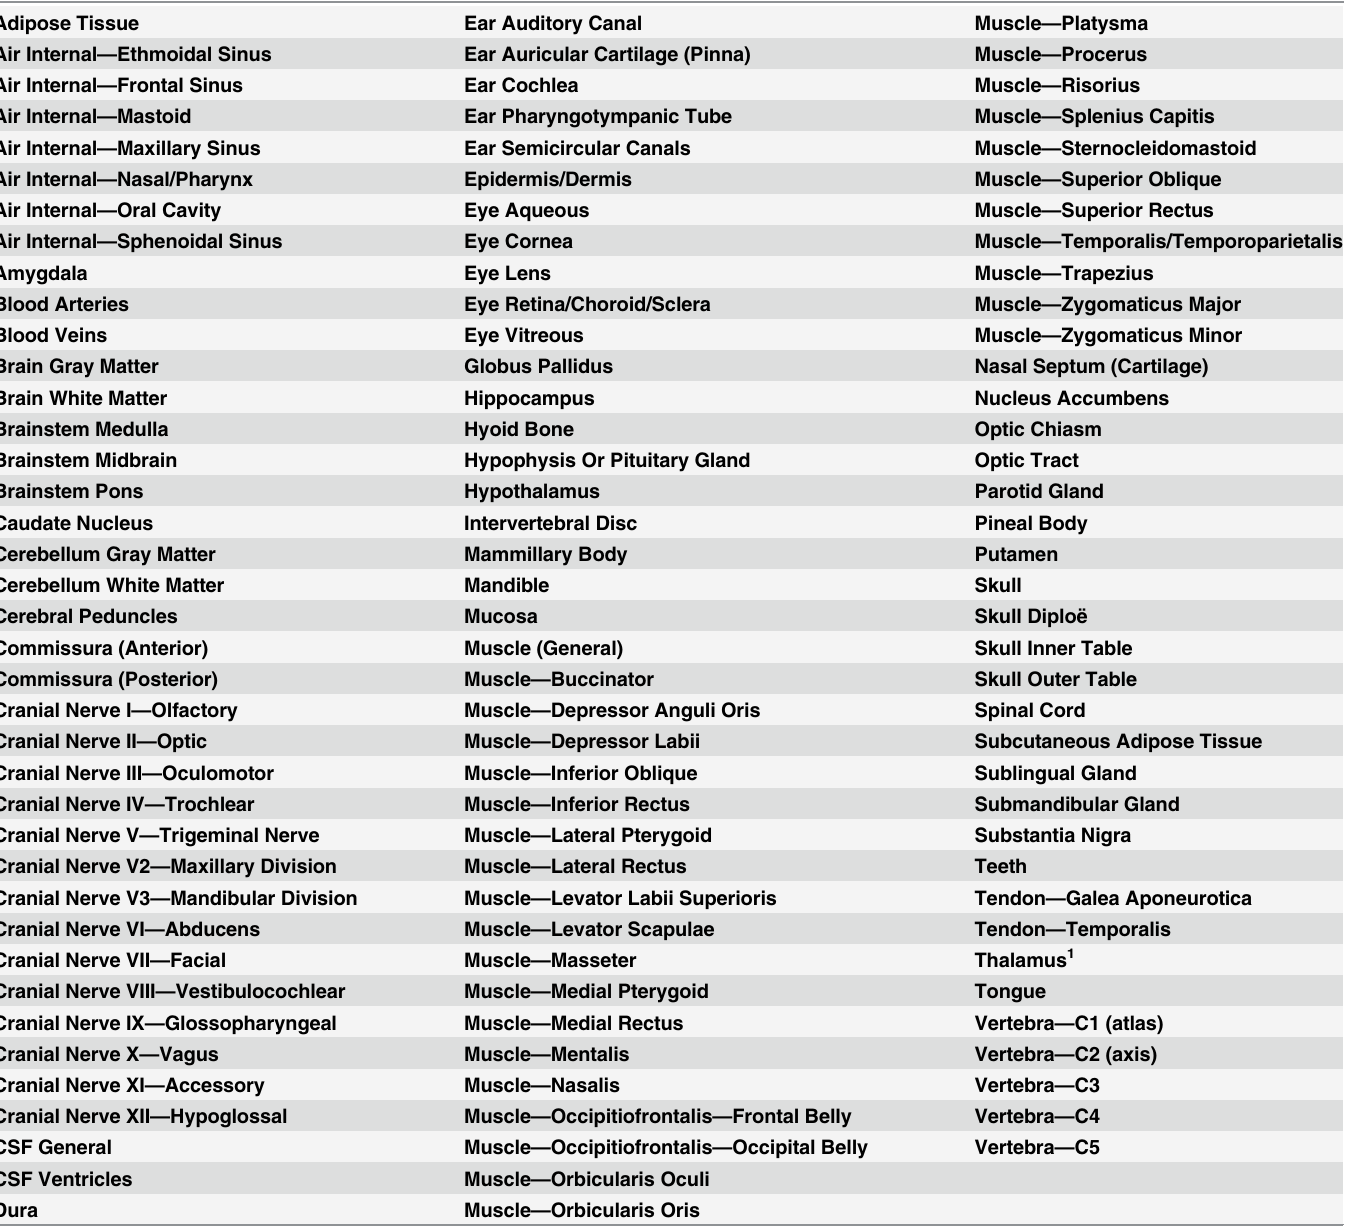
Table 1. List of the segmented